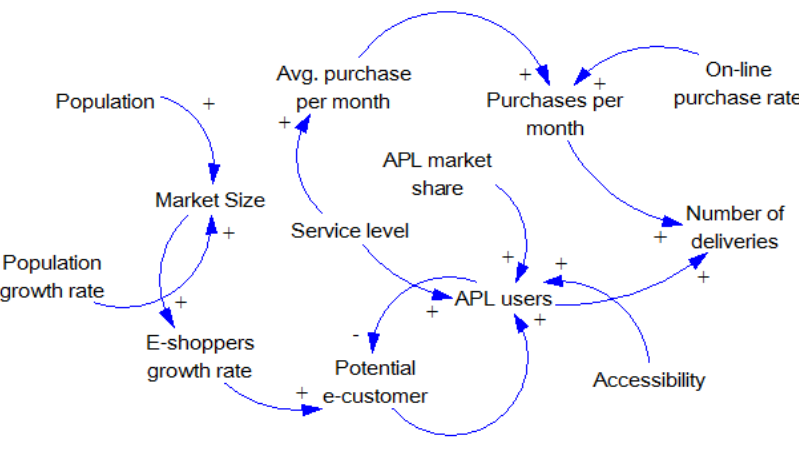
Figure 5. The automated parcel locker (APL) system causal-loop